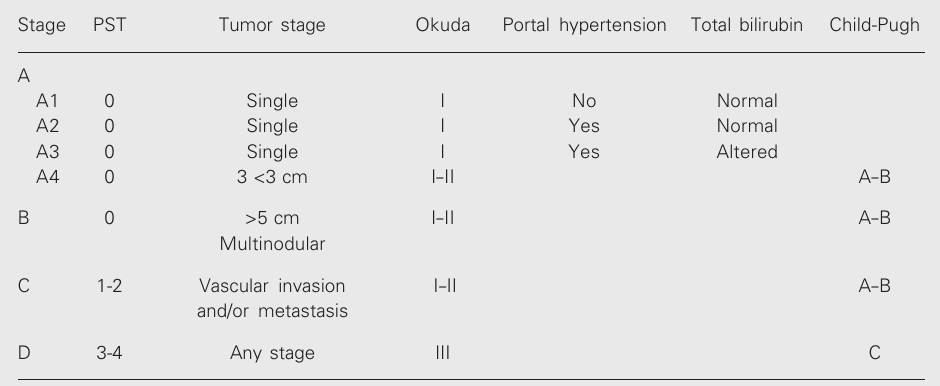
Table 2. Barcelona Clinic Liver Cancer (BCLC) Group classification of hepatocellular carcinomas (29). Stage PST Tumor stage